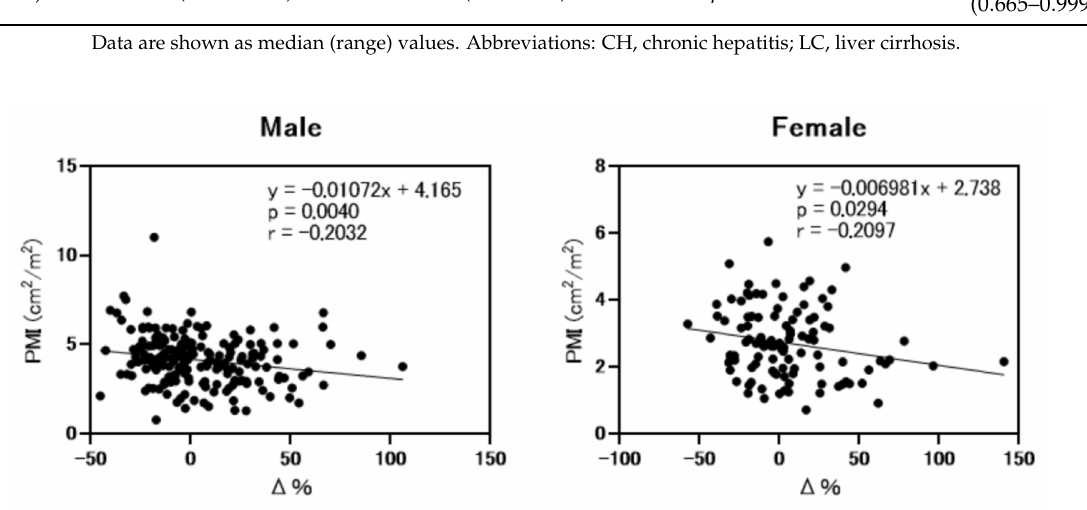
Figure 2. Correlation between psoas muscle mass index and differences between eGFRcre and eGFRcys. PMI; psoas muscle mass index. ∆ %; ∆ eGFRcre-cys (%) (eGFRcre-eGFRcys/eGFRcre × 100). Analysis performed by Spearman’s rank correlation